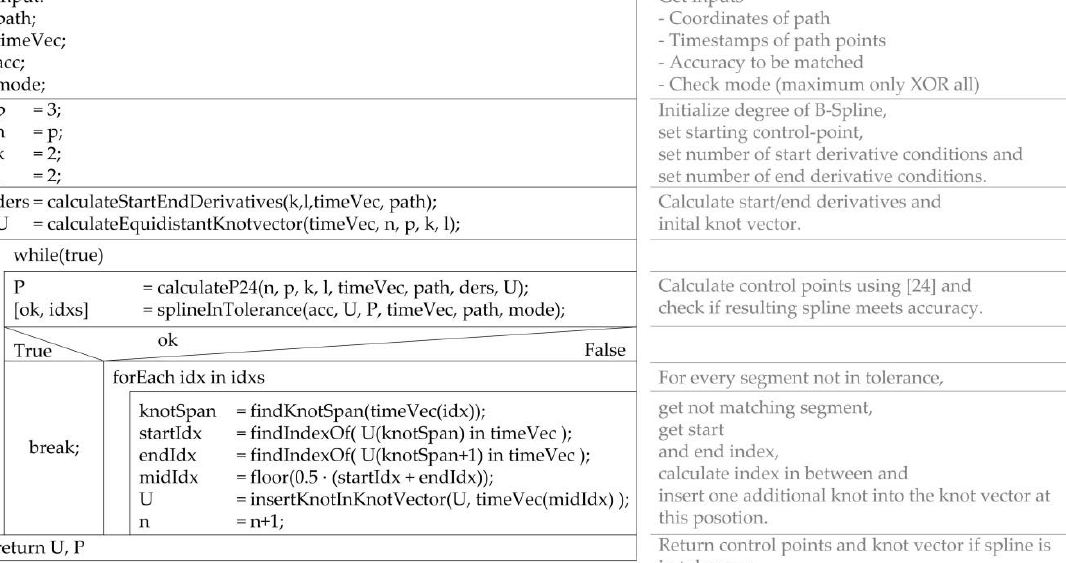
Figure 4. B-spline-based iterative algorithm bsITER, using [21]. msITER : this approach represents a very simple implementation of an iterative algorithm, Figure 5. It searches step by step for the shortest spline segment that meets the requirements. As described above, the considered segment is halved if it does not meet the requirements. The segment boundaries are thereby always set to already given, optimized points. If a segment fulfilling the requirements is found, a further run with the remaining points is performed. It is expected that the algorithm will be more performant than B-spline approaches with a similar or smaller amount of data.